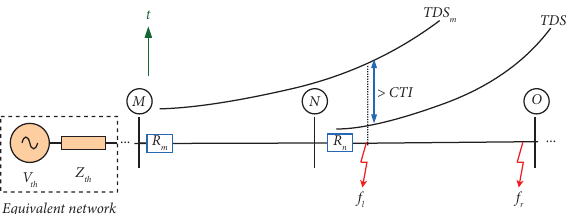
Figure 1: Distribution feeder with adequately coordinated 51